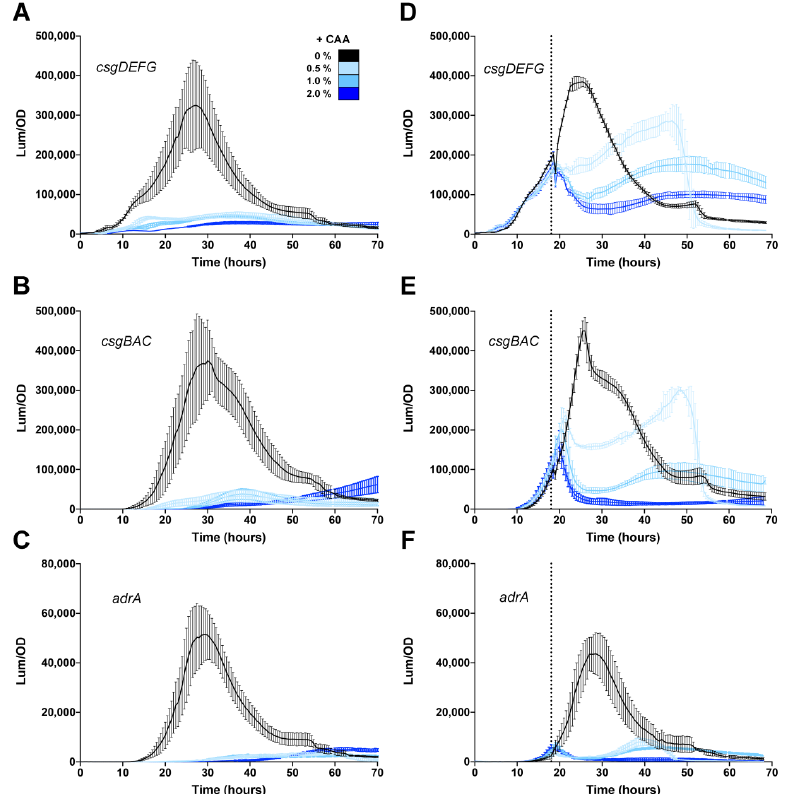
Figure 5. The csgD biofilm regulatory network in Salmonella is repressed by the addition of amino acids. Expression of csgDEFG ( A , D ), csgBAC ( B , E ), and adrA ( C , F ) was measured during growth of S. Typhimurium 14028 at 28°C in media premixed with 0.5%, 1.0% or 2.0% casamino acids ( A – C ) or in media where casamino acids were added during growth (D, E, F; the dotted line represents the time of addition at 18 h). For each graph, luminescence (light counts per second) divided by the optical density at 600 nm (Lum/OD) is plotted as a function of time and each curve represents a single growth condition. The mean and standard deviations are plotted from three biological replicate experiments measured in triplicate.